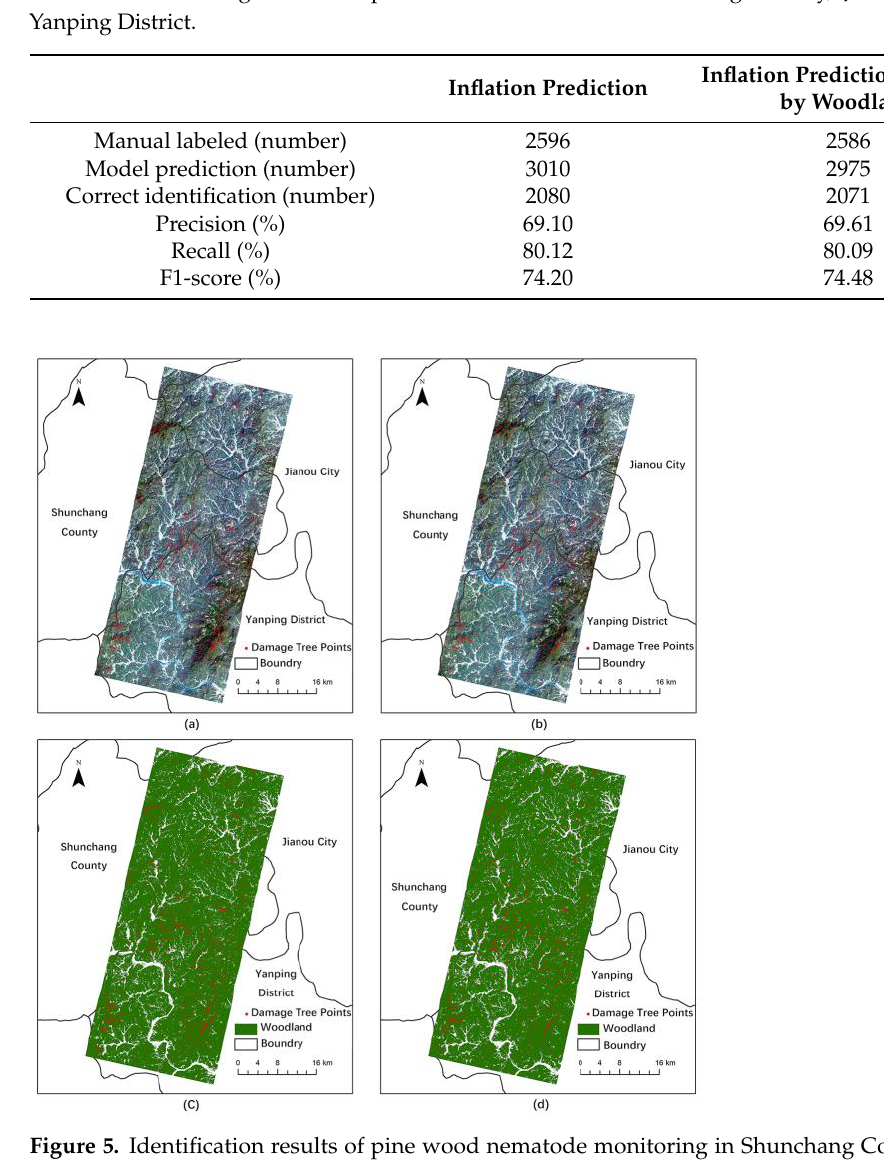
Figure 5. Identification results of pine wood nematode monitoring in Shunchang County, Jianou city, and Yanping District. ( a ) Results of selected swelling prediction, ( b ) results of manual labeling, ( c ) results of selected swelling prediction combined with extraction by stand, and ( d ) results of manual labeling combined with extraction by stand.